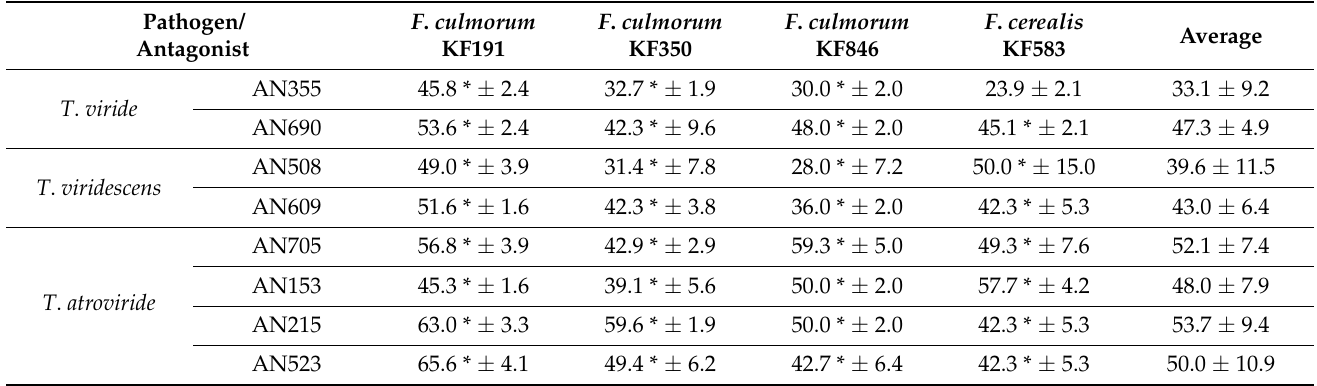
Table 1. Estimated inhibition (in % ± SD) of mycelial growth of Fusarium spp. by Trichoderma spp. after 5 days of co-incubation on PDA medium ( n = 3).